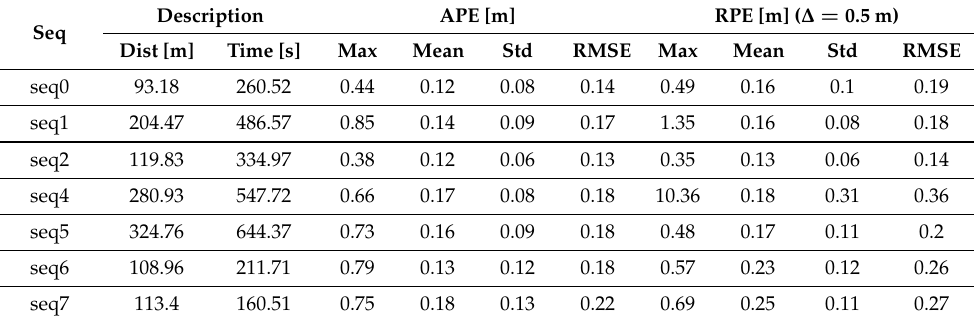
Table 6. Álora dataset description and localization